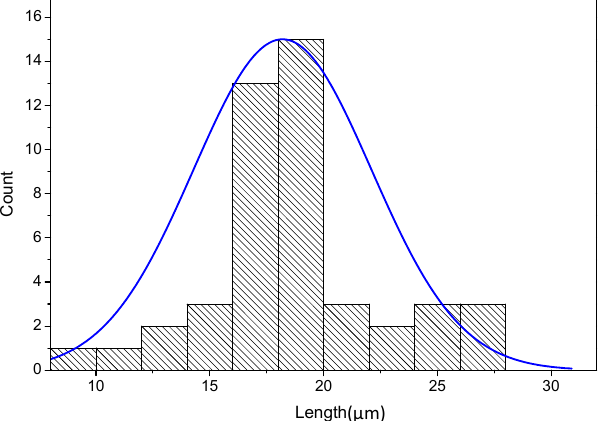
Figure 3. Particle size distribution in the AC-Pd2 sample.